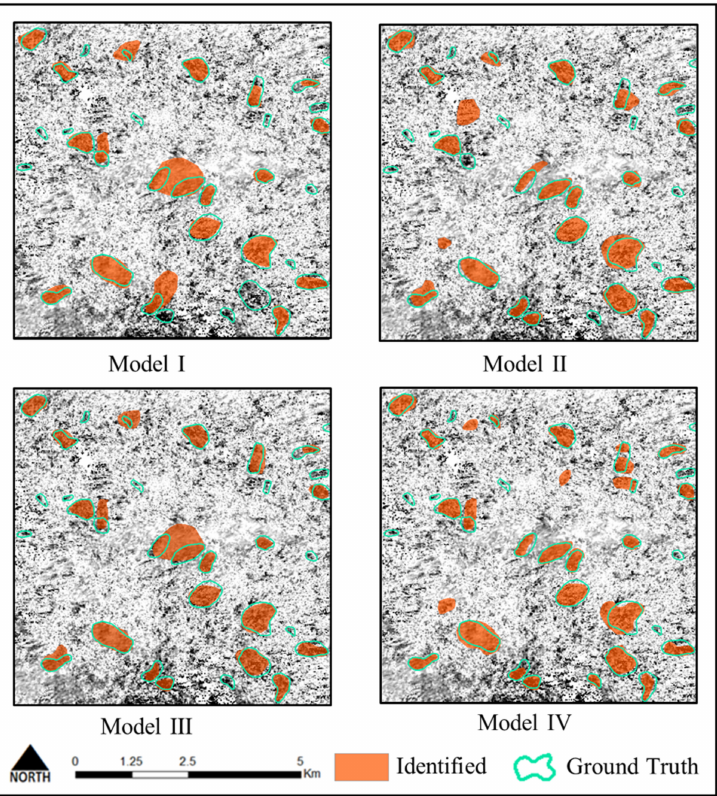
Figure 21. Comparison of the different modules in test area